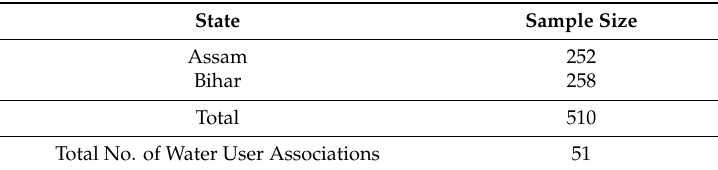
Table 1. Survey sample